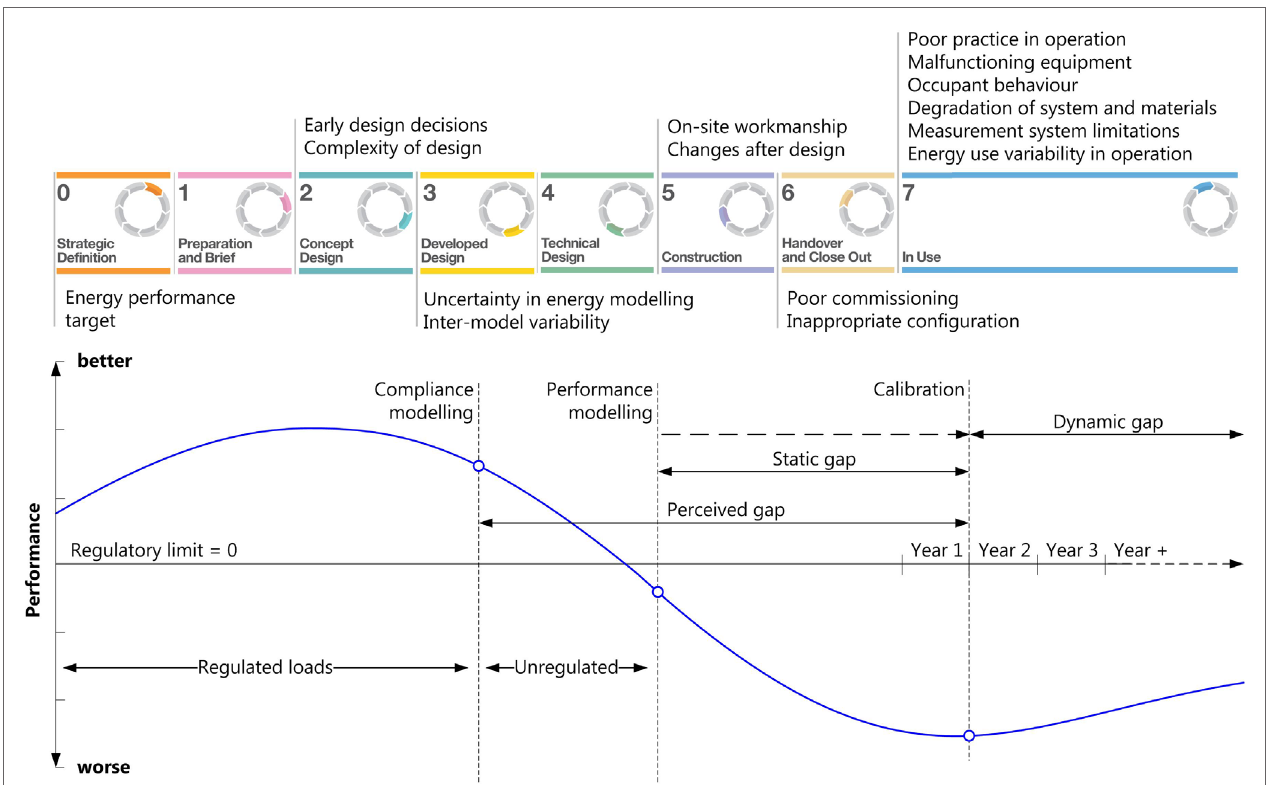
FiGURe 4 | Underlying causes existent in different RiBA stages [adapted from RiBA (2013)] and S-curve visualization of performance throughout the life cycle [adapted from Bunn and Burman